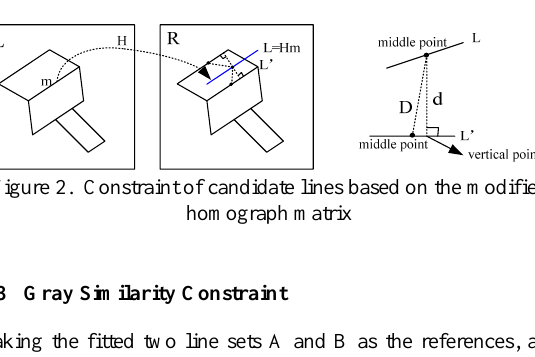
2.5 Brightness Contrast Constraint After the epipolar constraint, it obtains the overlap segments of homologous lines. The brightness contrast in a local buffering region along both sides of the matching lines can be used to further disambiguate the line matching.